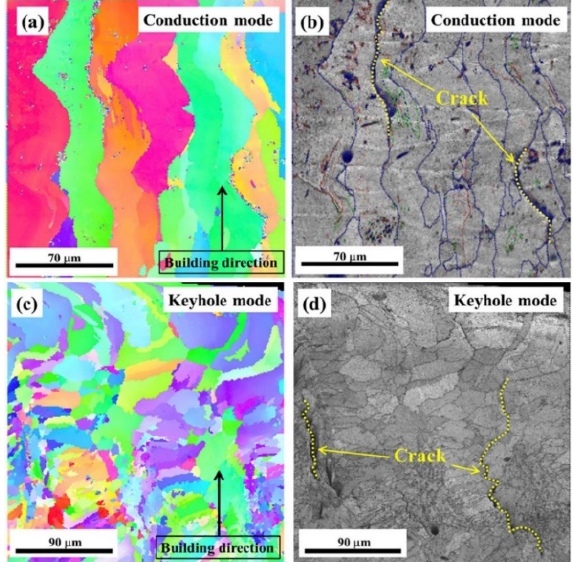
Figure 45. EBSD maps for two melting modes. ( a ) orientation image map and ( b ) grain boundary misorientation angle map in conduction mode, ( c ) orientation image map and ( d ) grain boundary misorientation angle map in keyhole mode [184]. Copyright 2017. Adapted with permission from Elsevier Science Ltd. under the license number 4803741018430 (Figure 10 [184]), dated 7 April 2020.